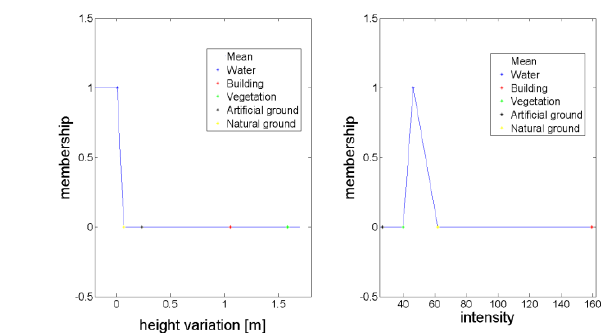
Figure 2: Membership functions of feature height variation (a) and intensity (b)